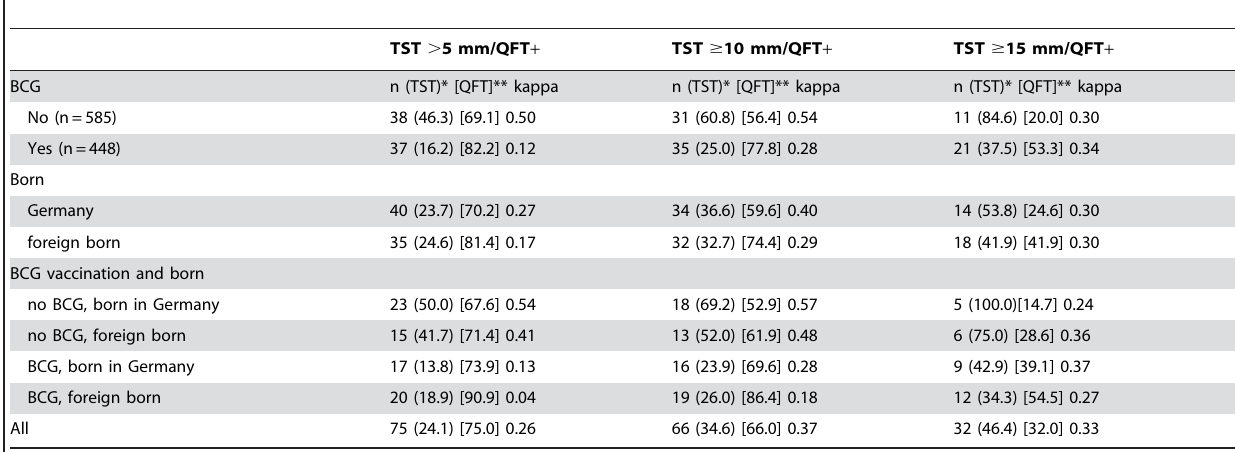
Table 2. Positive results of the TST with different cut-off points confirmed by QFT for various subgroups and kappa-value.